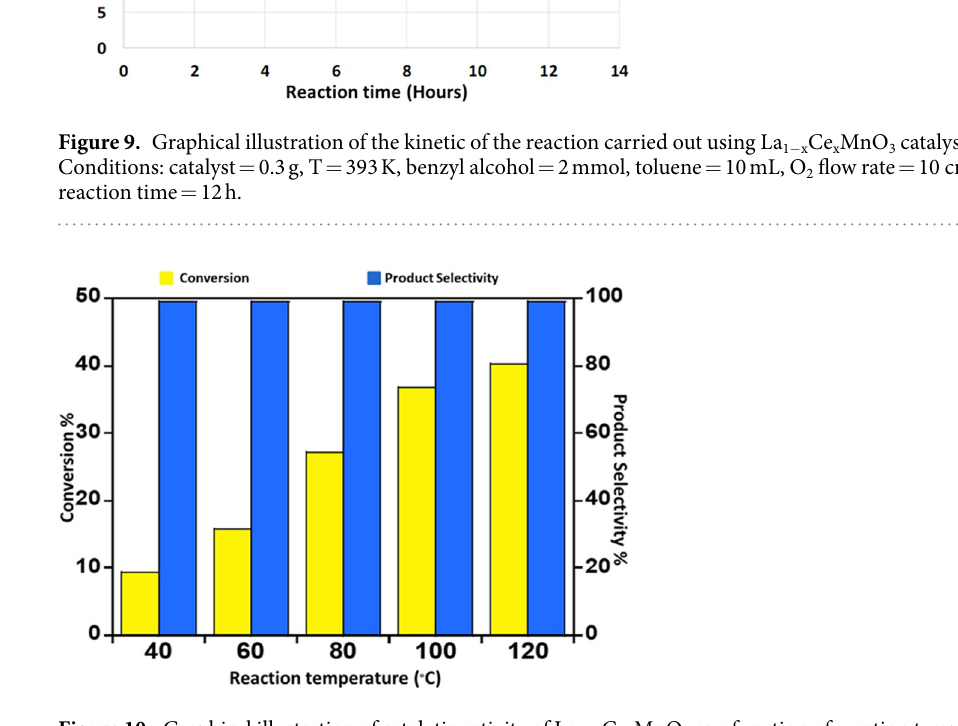
Figure 10. Graphical illustration of catalytic activity of La 1 − x Ce x MnO 3 as a function of reaction